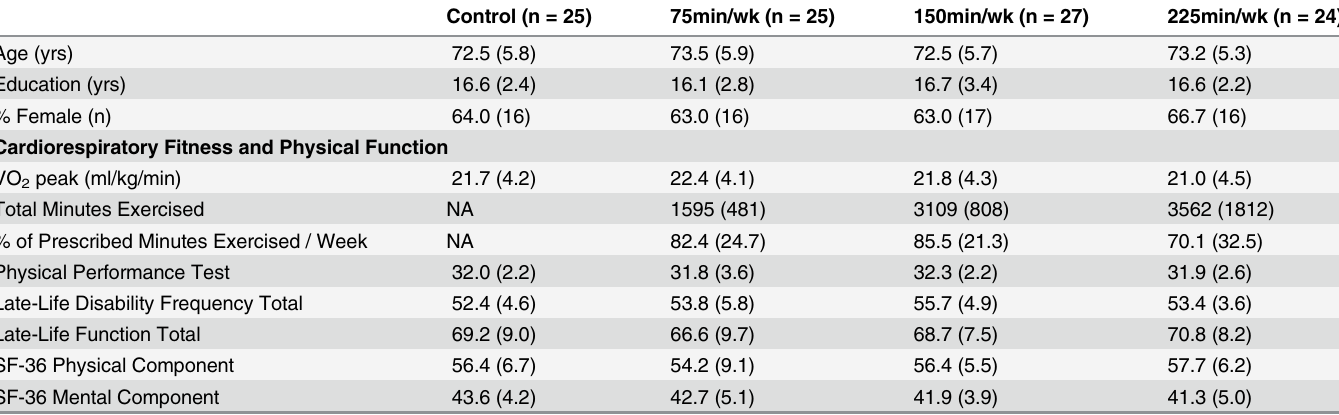
Table 1. Demographic and descriptive baseline